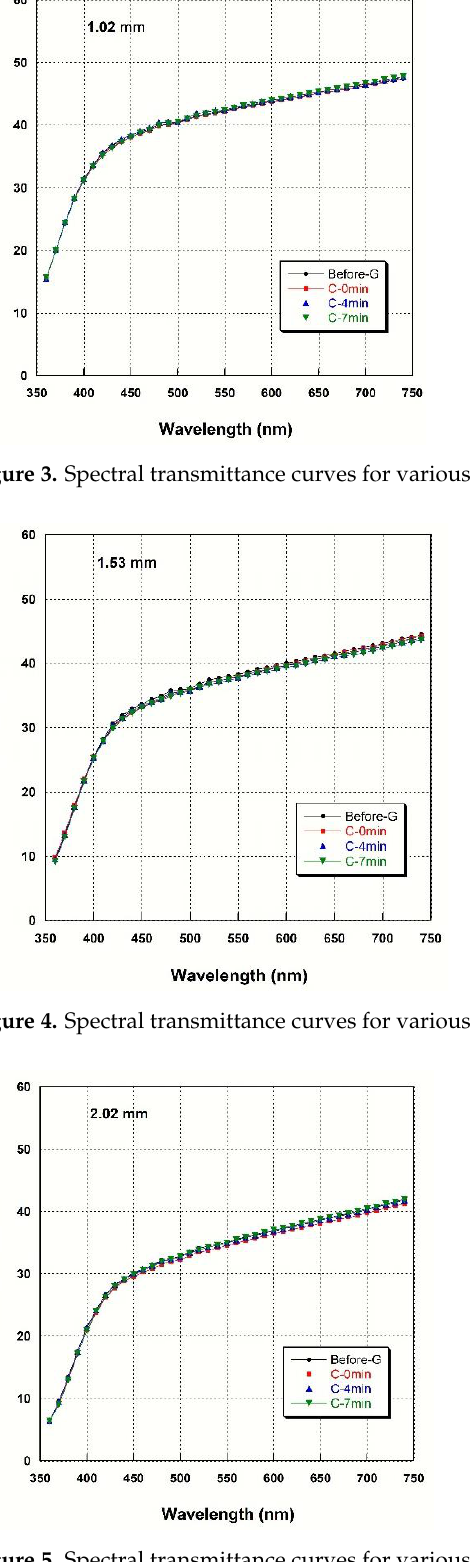
Figure 5. Spectral transmittance curves for various cooling rates at a thickness of 2.02 mm. Table 4. AT as a function of cooling rate for specimens with various thicknesses (mean ± SD).